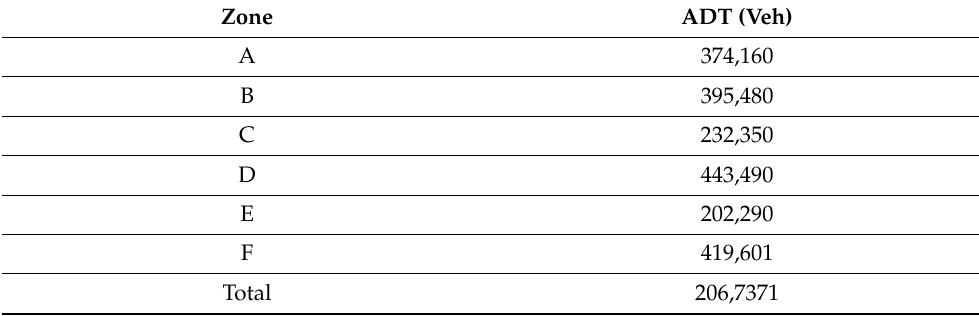
Table 3. ADT for Each